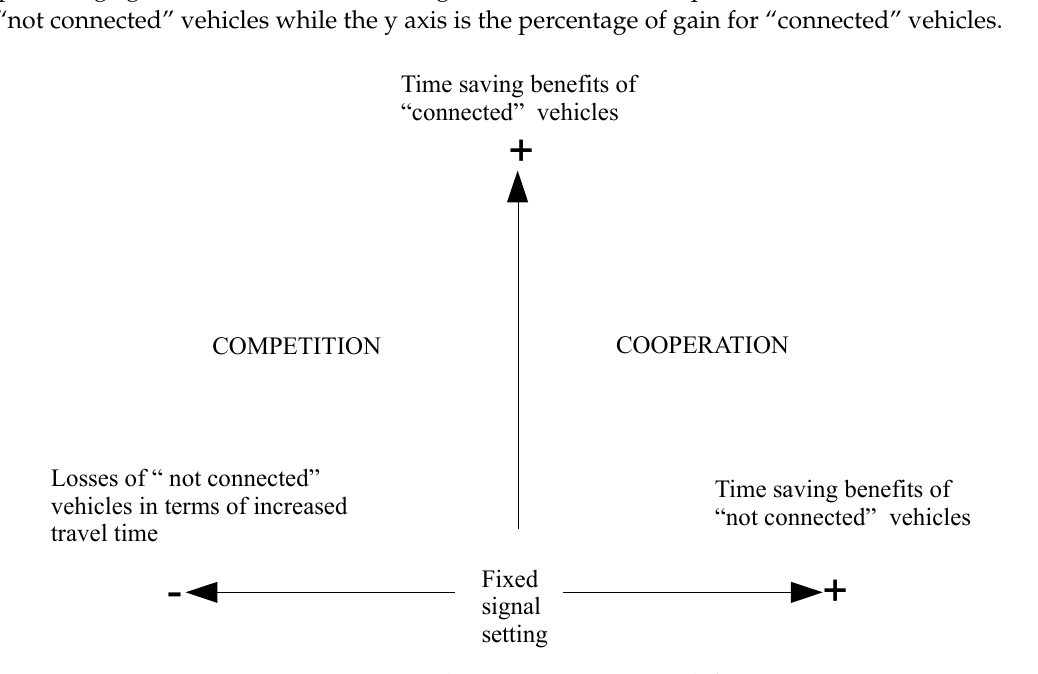
Figure 2. Coopetition (competition-cooperation) diagram.